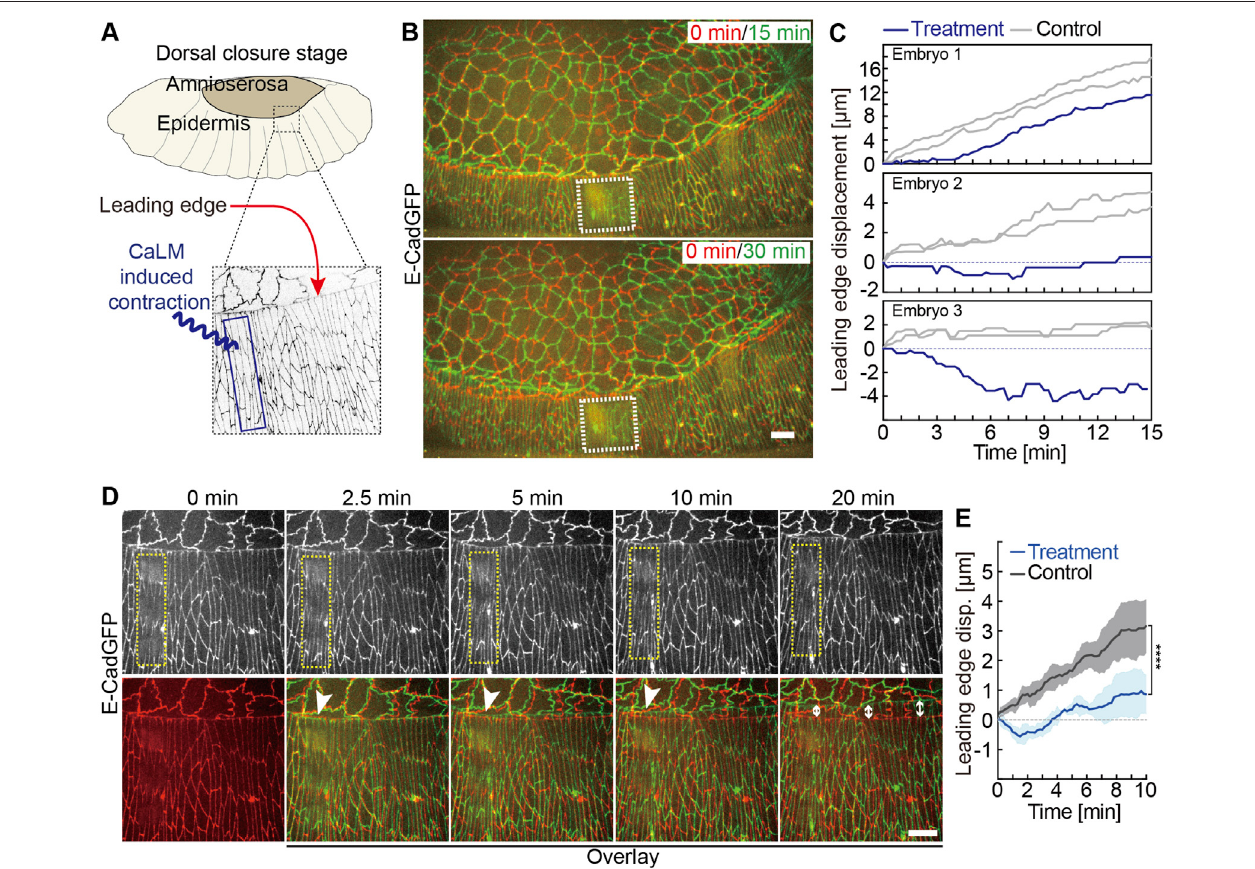
( Figure 4E ). Our data show that optochemically induced contractions in the lateral epidermal cells temporarily and locally antagonized DC. Together with the genetic Rho V14 expression data ( Supplementary Figure S2 ), our results suggest that DC requires elongation in epidermal